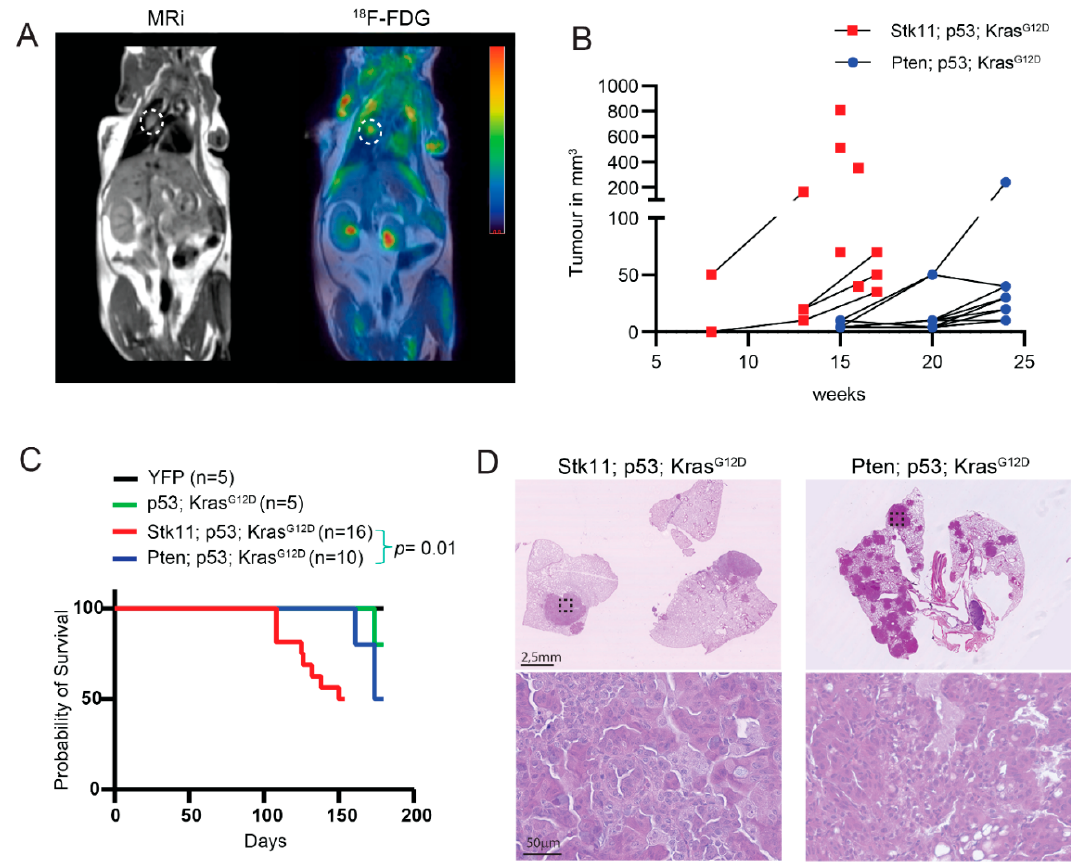
Figure 3. Loss of Stk11 accelerated lung tumor progression. Mice inoculated with AAV particles containing sgRNAs were followed for lung cancer progression by PET/MRI scanning. ( A ) Lung cancer was imaged by PET/MRI with 18 F-FDG as tracer. The white dotted circle indicates the tumor. A representative picture is shown ( n > 10). ( B ) Quantification of